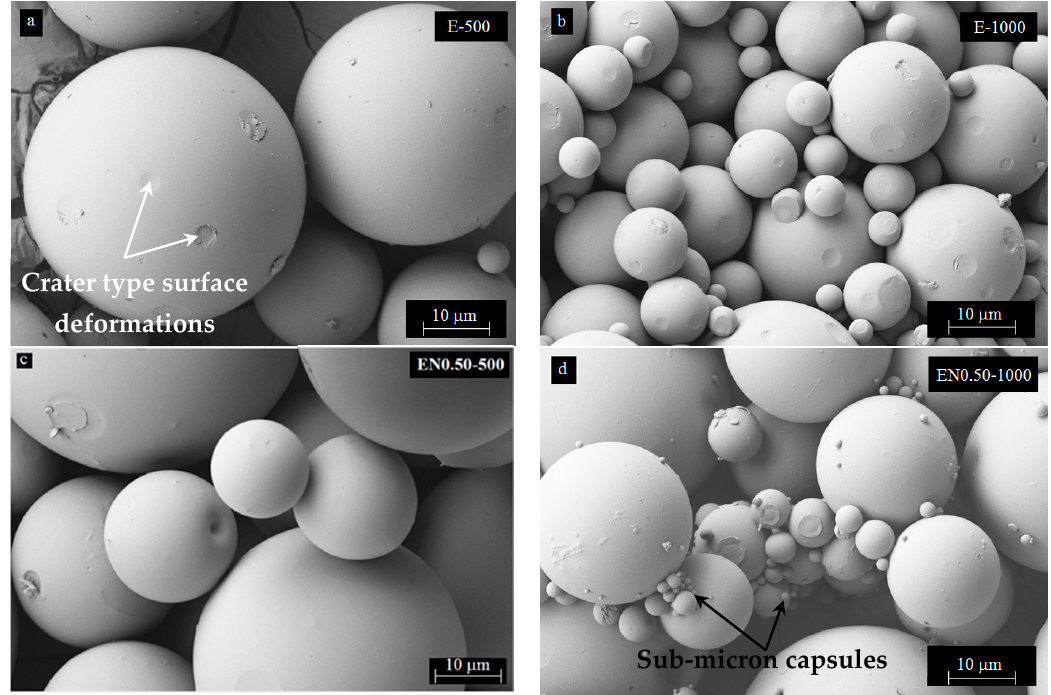
Figure 8. SEM micrographs showing the exterior surface of PMMA microcapsules containing epoxy/CNT mixtures prepared at: ( a ) 500 rpm with no CNTs, ( b ) 1000 rpm with no CNTs, ( c ) 500 rpm at 0.5 wt % CNTs, and ( d ) 1000 rpm at 0.5 wt % CNTs.